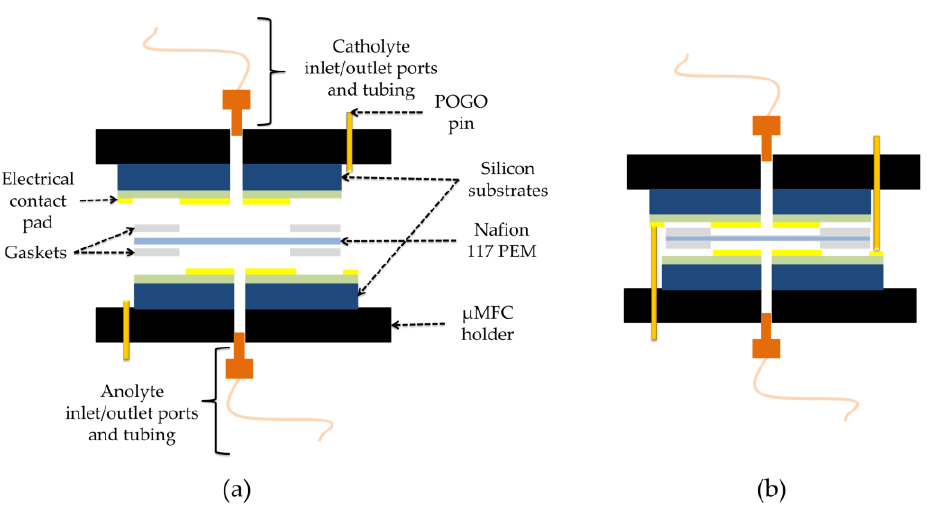
Figure 3. Schematic of µMFC: ( a ) extended view; ( b ) assembled view.